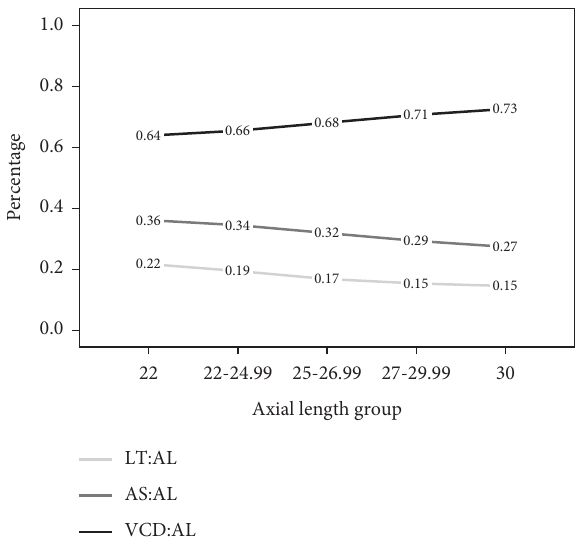
Figure 3: Proportions of lens thickness, anterior segment, and vitreous chamber depth stratified by axial length in Chinese cat- aract